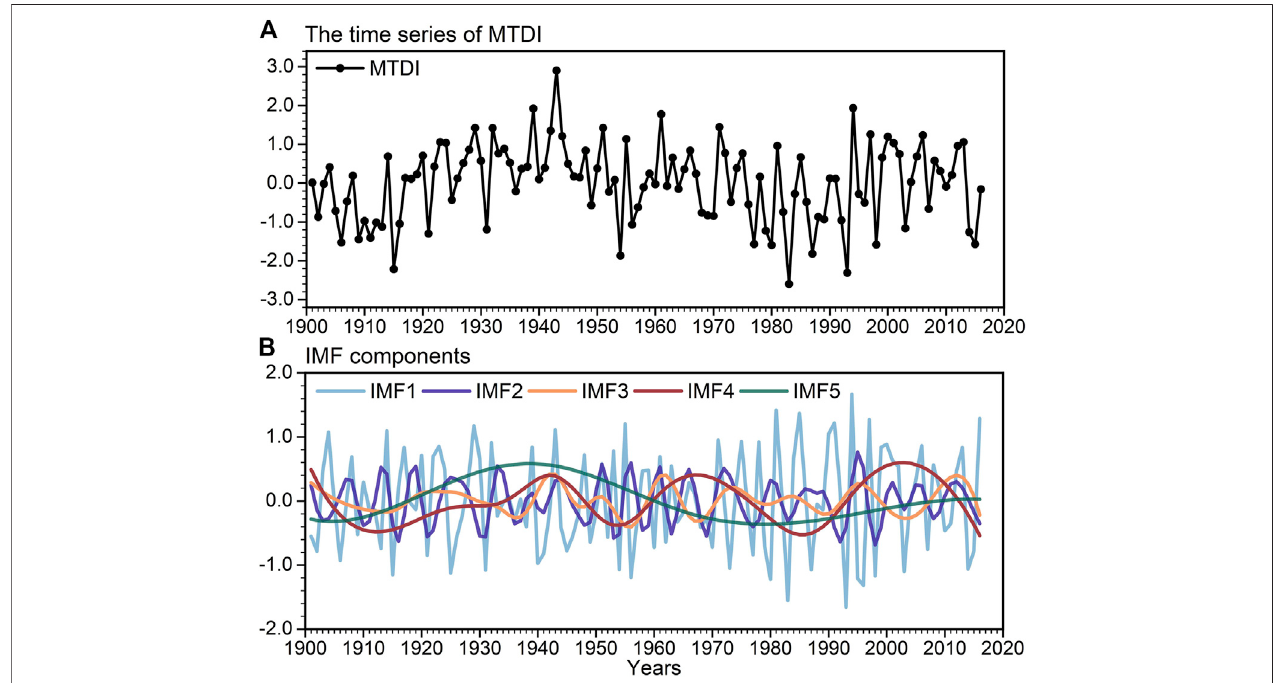
FIGURE3|(A) TimeseriesofMeridionaltemperaturedifferenceindex(MTDI)for1901 – 2016. (B) IMFcomponentsoftheMTDIduring1901 – 2016basedonEEMD decomposition.